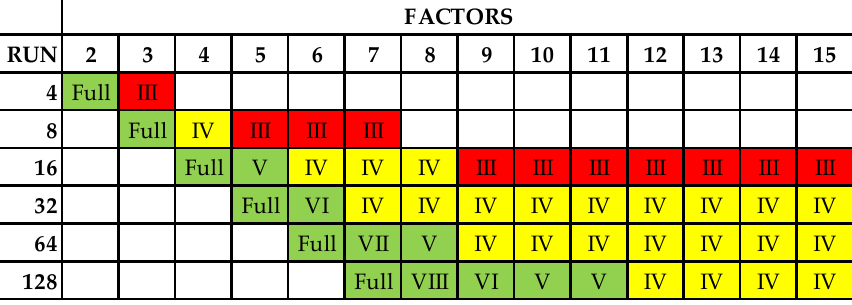
Figure 5. Different available resolutions.